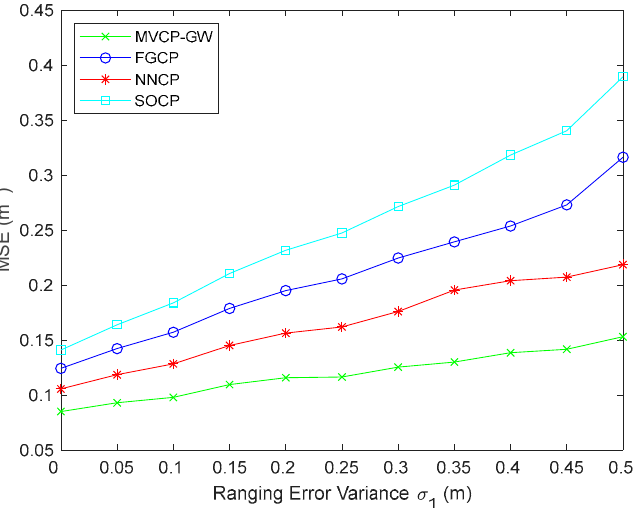
Figure 3. The relation diagram of positioning error MSE with the increase of ranging error variance σ 1 .